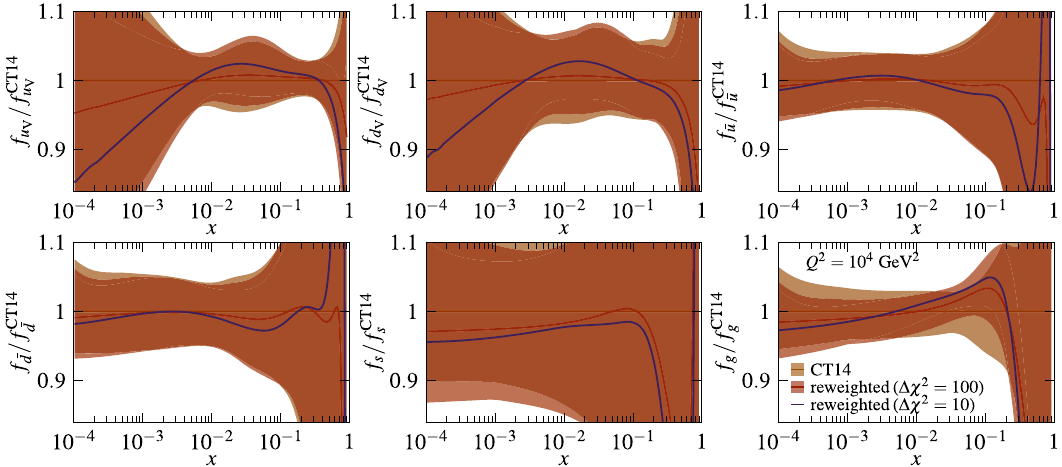
Fig. 3 The impact of reweighting on CT14 NLO PDFs at Q 2 = 10 4 GeV 2 . The original CT14 PDFs are shown in orange, with the solid line representing the central set PDFs, the ratio to which is shown in